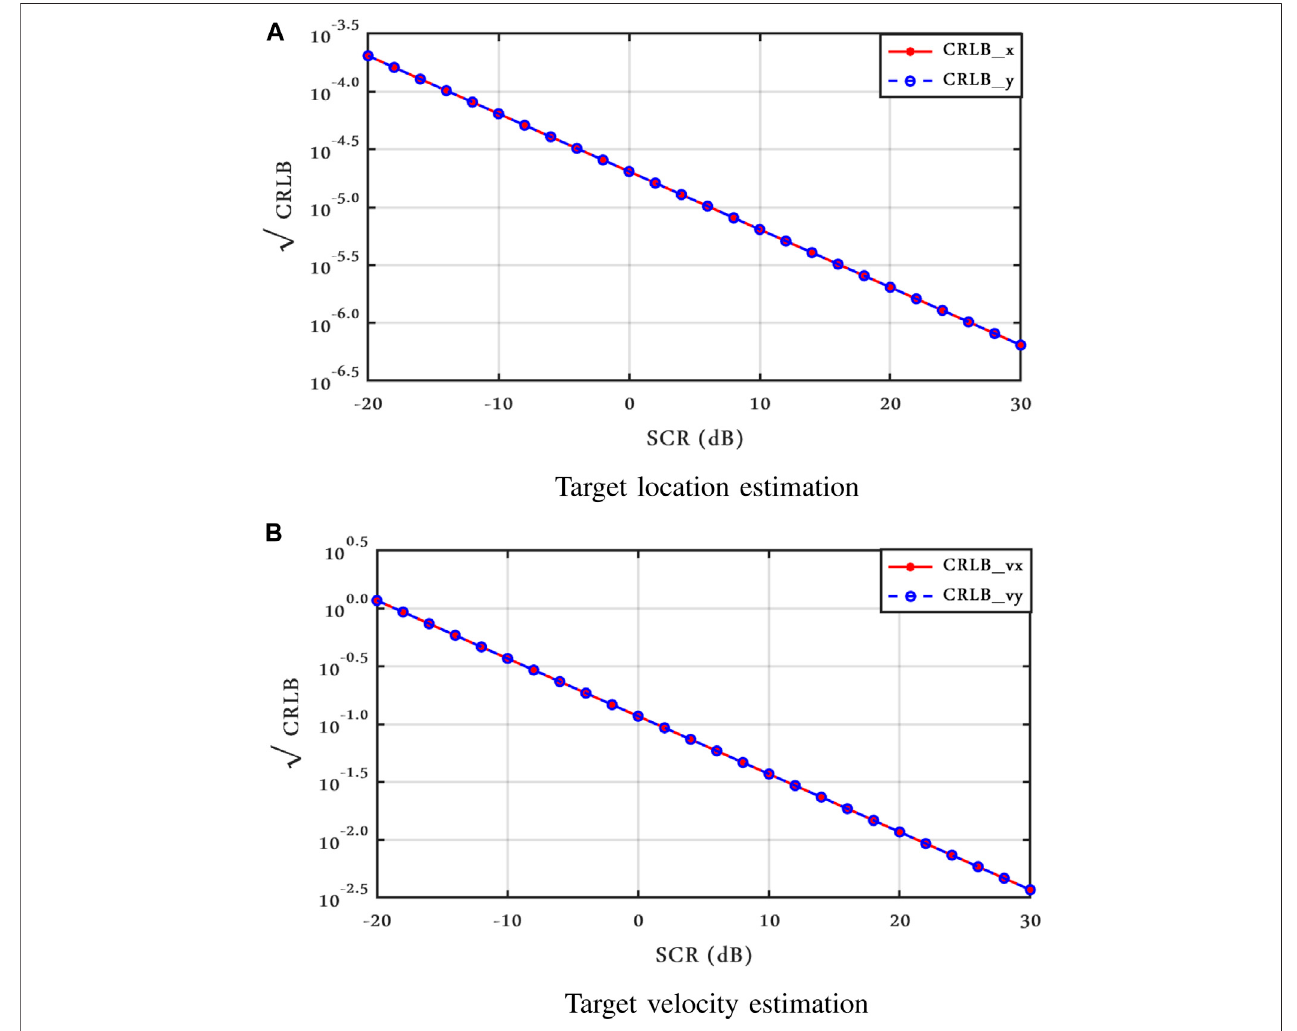
FIGURE 4 | CRLB for target location and velocity estimation in Clutter Model II.